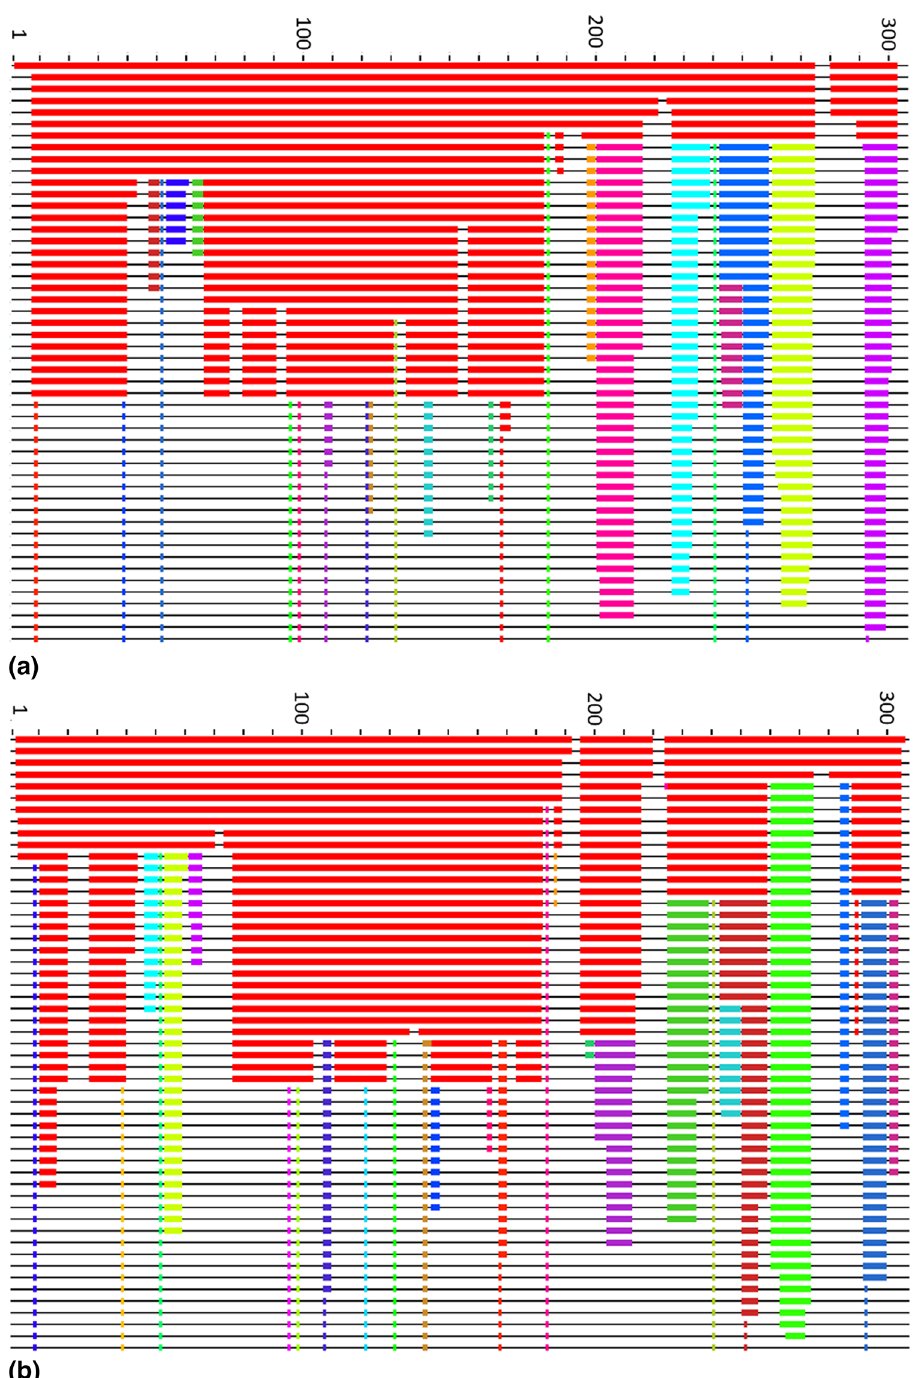
Figure 2. Examples of rigid cluster decompositions for different SARS-CoV-2 protein structures. ( a ) Shows the monomer of the crystal structure of the COVID-19 main protease in apo form (PDB: 6m03) and ( b ) gives results for chain A of a complex resulting from the reaction between the SARS-CoV main protease and a carbamate (PDB: 6y7m). Distinct rigid clusters of the polypeptide chain appear as coloured blocks along the protein chain with each C α labelled from its N-terminal at 1 (left edge) to its C-terminal (right edge). The coloring and choice of blocks follows the same logic as detailed in Fig. 1 except that the left most data columns are not shown for clarity. The energy cutoff E cut decreases in the downward direction towards larger, more negative E cut magnitudes; rigid clusters break up and more of the chain becomes